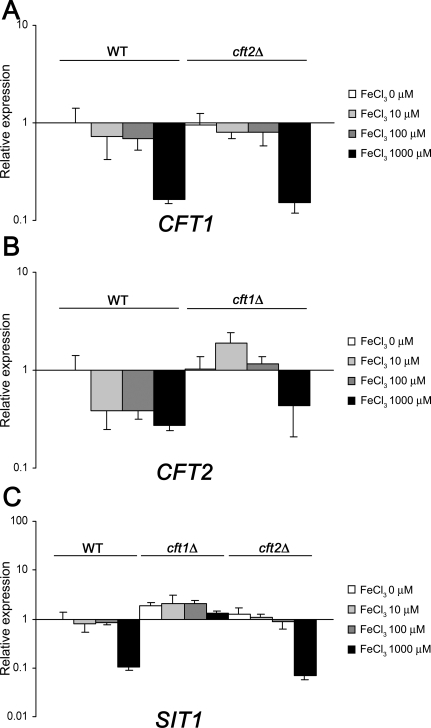

CFT1 Influences Transcript Levels for CFT2 and the Siderophore Transporter Gene SIT1
(A) Transcriptional regulation of CFT1 in the cft2 mutant was monitored by quantitative real-time RT-PCR after growing cells in media containing different concentrations of iron (0, 10, 100 and 1,000 μM of FeCl3).(B) Transcriptional regulation of CFT2 in the cft1 mutant was monitored by quantitative real-time RT-PCR in the same culture conditions.(C) Transcription of SIT1 was analyzed in both the cft1 and the cft2 mutant strains in parallel experiments. All data were normalized by using ACT1 as an internal control, according to the ΔΔCt method, and are presented as fold changes (y-axis). Data are from four replicates and bars represent the standard deviations.